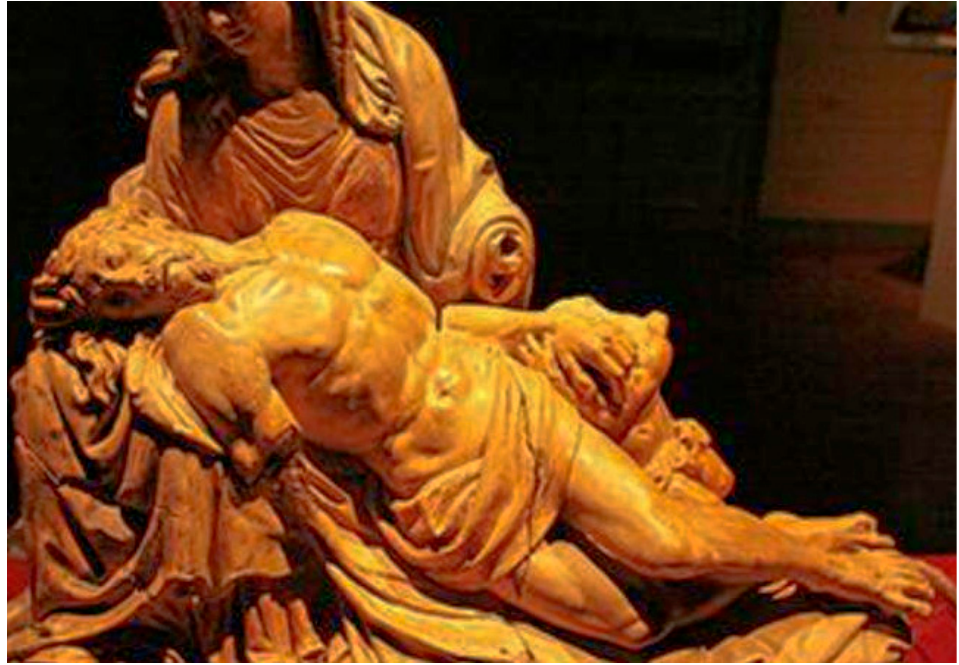
Figure 9. Terracotta model of Michelangelo for his iconic Pietá. A close-up view of a section.